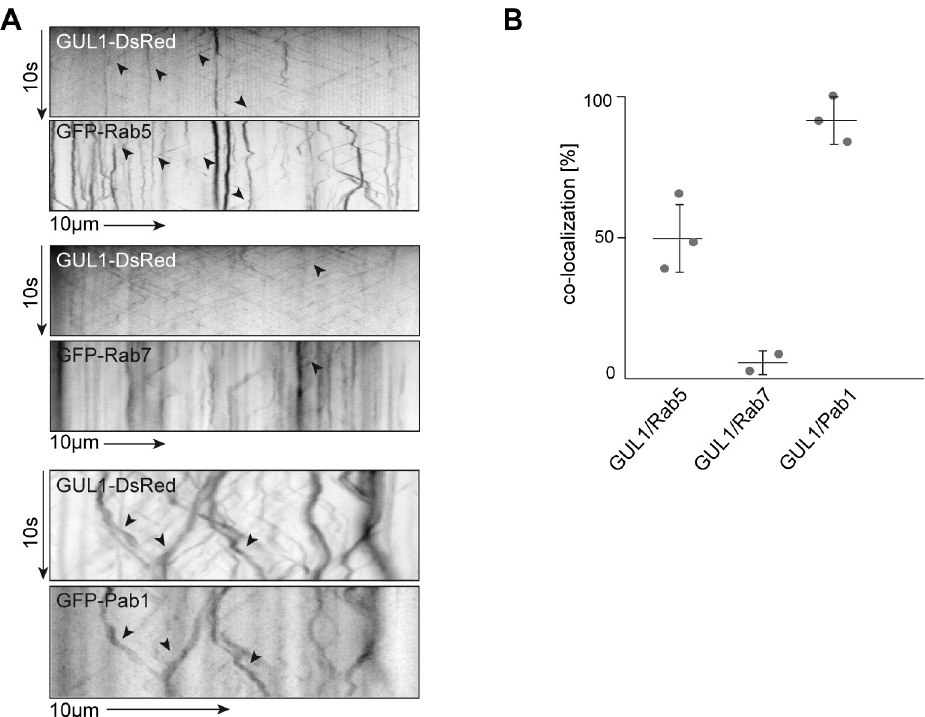
Fig 8. Kymographical analysis of co-localization between GUL1-DsRed and GFP-Rab5 and GFP-Rab7. (A) Example of kymographs, used for the analysis of co-localization of GUL1-DsRed and GFP-Rab5 and GFP-Rab7. Fluorescence signals were detected simultaneously using dual-view technology. Kymographs were generated for a distance of at least 50 μ m. Processive co-localizing signals are marked by black arrowheads. (B) Quantification of co- localization in percent. The shuttling of GUL1-DsRed and GFP-Rab5 was measured in 11 different hyphae per strain. The shuttling of GUL1-DsRed and GFP-Rab7 was measured in 4 different hyphae per strain. Analysis of Rab5 was done in triplicates. Analysis of Rab7 was done in duplicates. Mean is indicated by a horizontal line, dots show means of each experiment, error bars indicate standard deviation (S6–S8 Movies, S5 Dataset).